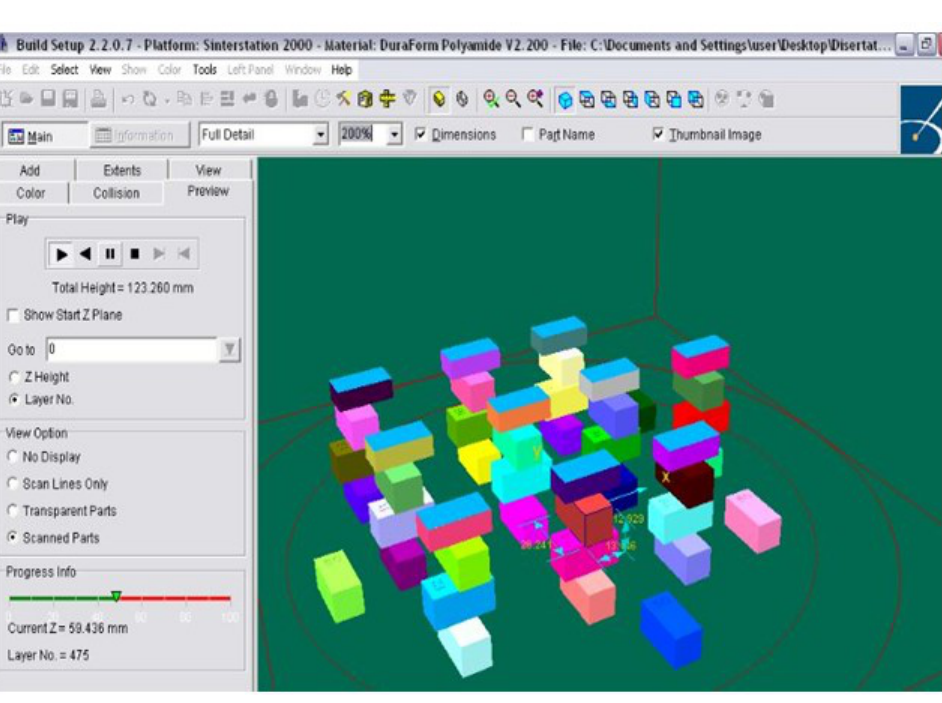
Figure 1. Compressive samples made by the DTM Sinterstation 2000 equipment. Samples’ position on the working area of the